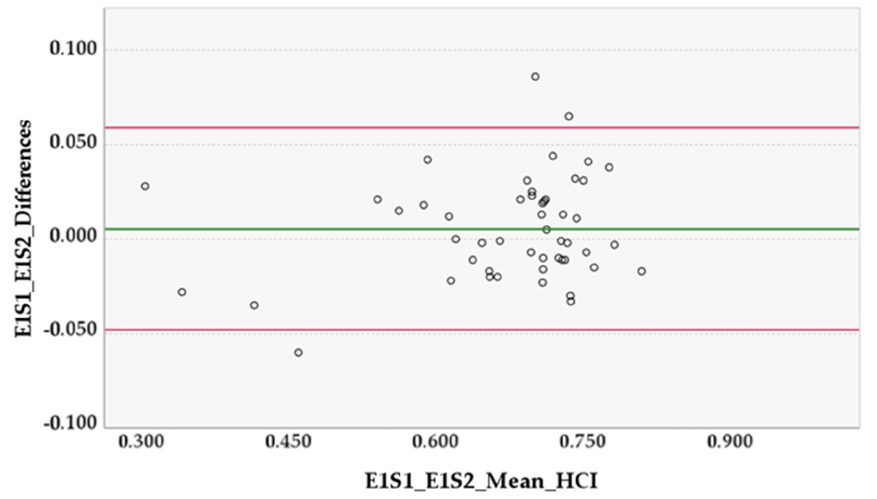
Figure 3. Differences between Examiner 1, Sessions 1 and 2 (E1S1 and E1S2). The horizontal lines represent the mean of the differences (0.005) and the upper and lower 95% limits of agreement, approximately 0.059 and − 0.048,